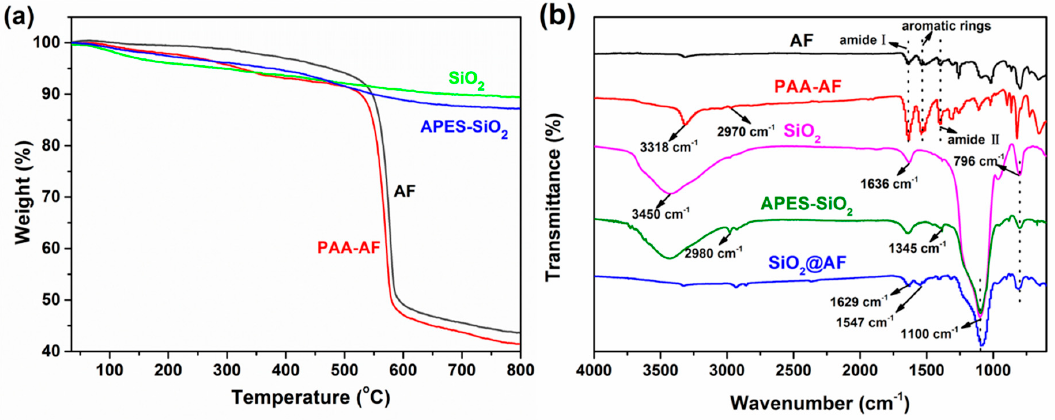
Figure 2. Thermogravimetric analysis (TGA) curves of SiO 2 , APES–SiO 2 , AF and PAA–AF ( a ).